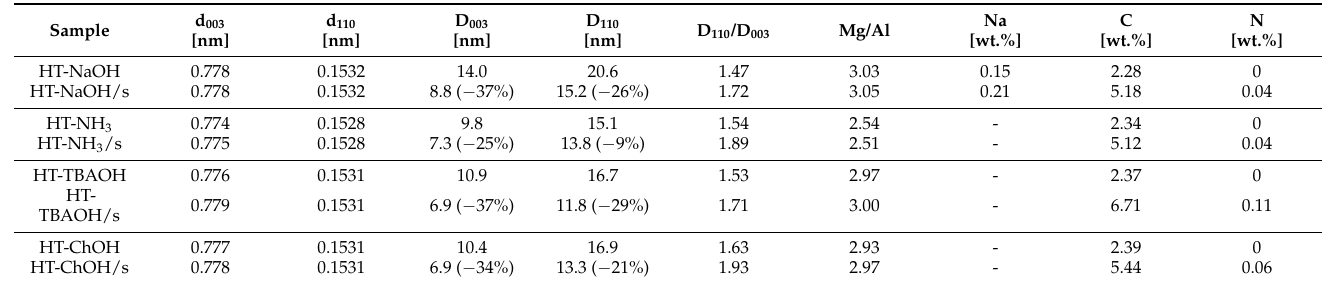
Table 1. Physico-chemical parameters of synthesized HT solids: interplanar d 003 and d 110 distances, crystal sizes in the c direction (D 003 ) and along ab plane (D 110 ), D 110 /D 003 aspect ratio, Mg/Al ratio, Na, C and N content. In brackets degree of crystal size reduction in the presence of